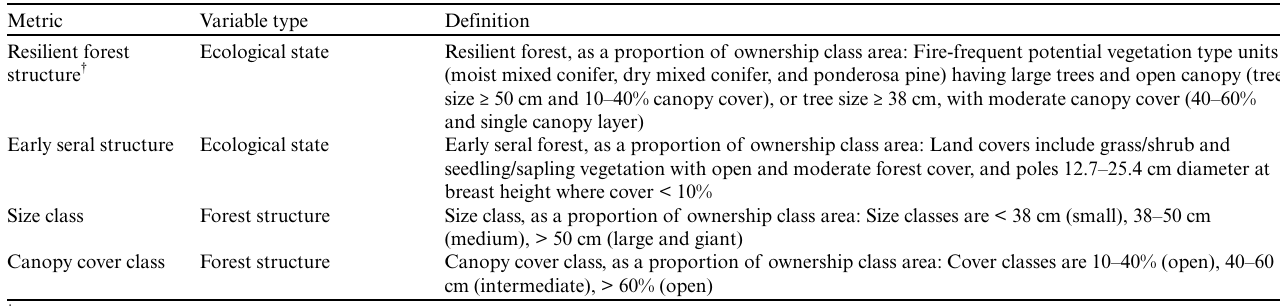
Table 2. Metrics of wildfire-resilient forest